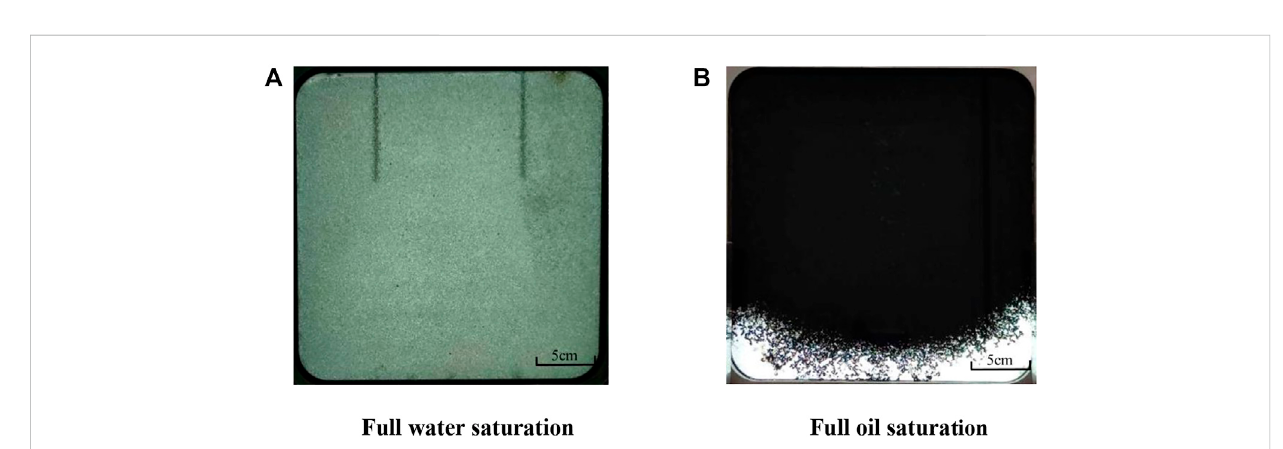
FIGURE 7 Model saturated water and saturated oil states. (A) Full water saturation. (B) Full oil saturation.